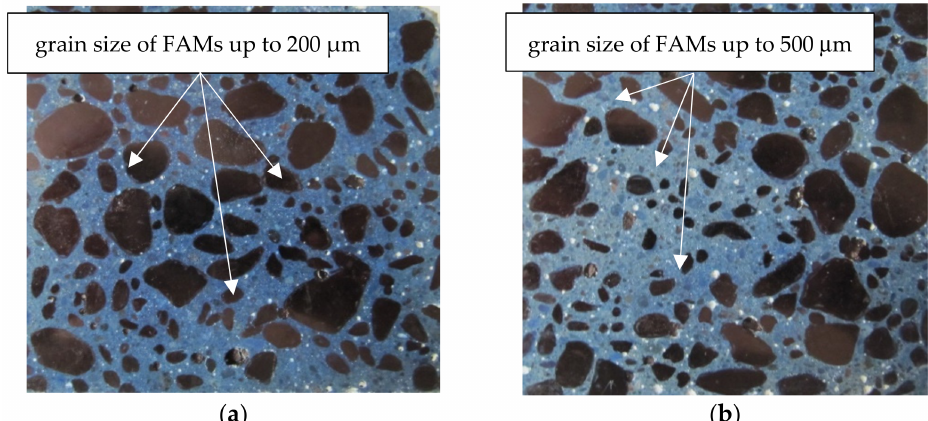
Figure 4. View of the concrete surface to evaluate the characteristics of air voids distribution using Rapid Air 457: ( a ) FAMs up to 200 µ m; ( b ) and FAMs up to 500 µ m.